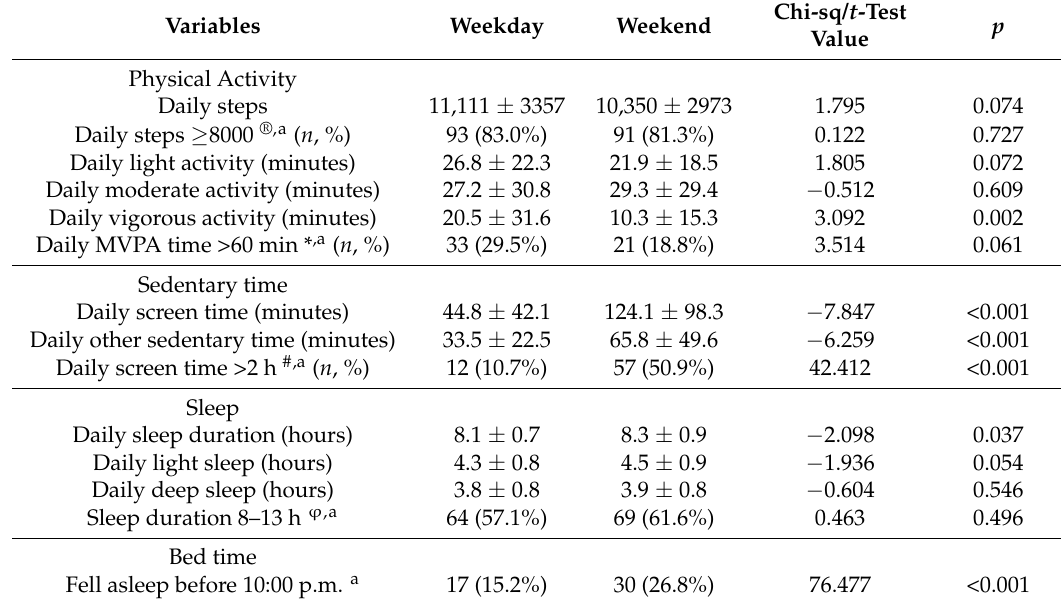
Table 2. Daily physical activity, screen time and sleep during the weekdays and weekends ( n = 112).